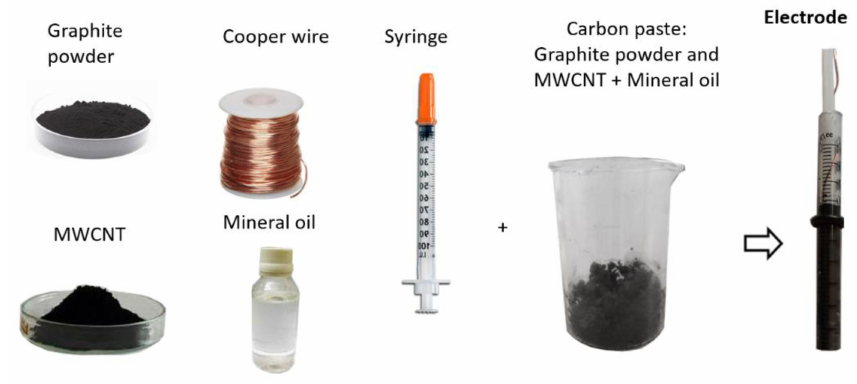
Figure 2. Materials and preparation of the working